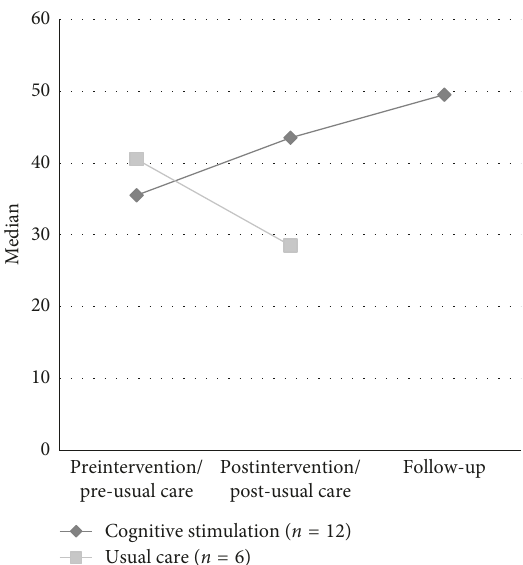
Figure 3: Median change of the CERAD total score (max. 111